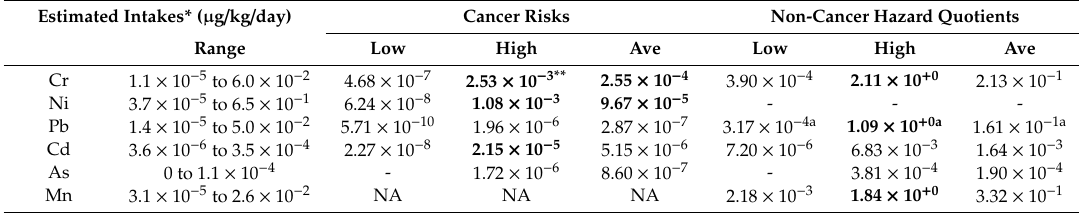
Table 4. Summary of estimated metal intakes, cancer and non-cancer risks from published metal concentration ranges in e-cigarette liquids and / or aerosols using U.S. Environmental Protection Agency (USEPA) reference exposure concentrations (RfCs), National Ambient Air Quality Standard (NAAQS), and cancer slope factors.